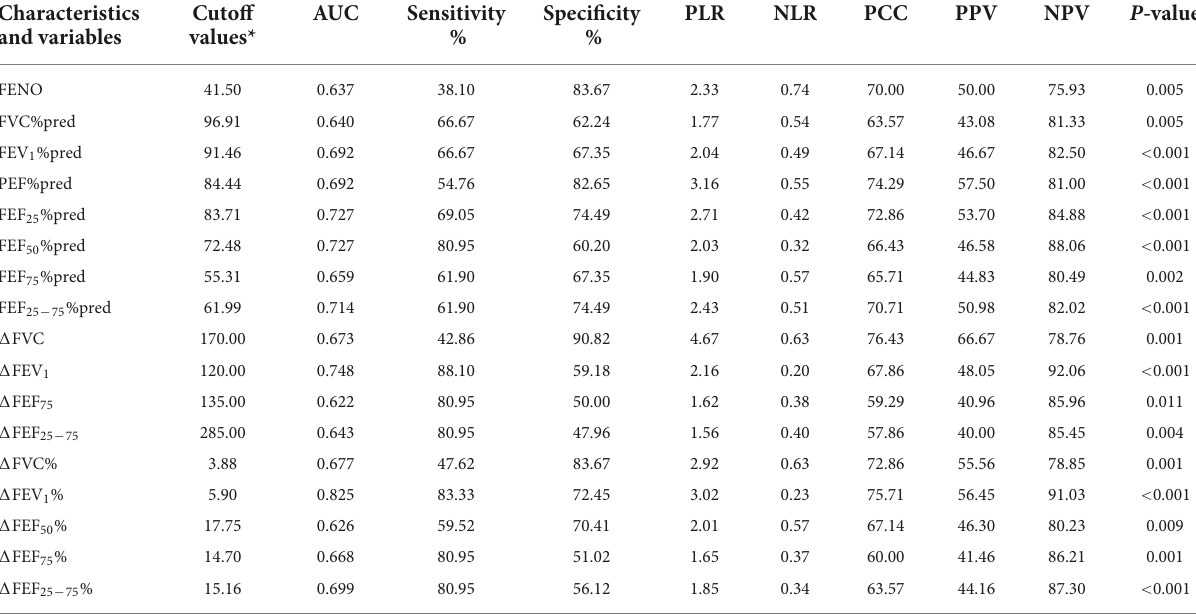
AUC, area under the curve; PLR, positive likelihood ratios; NLR, negative likelihood ratios; PPV, positive predictive value; NPV, negative predictive value; PCC, percentage correctly classified; P -value, the p value of logistic regression test. ∗ The cut-off points were selected by maximizing the sum of sensitivity and specificity; The other abbreviations are as defined in Table1 . (cid:49) FEV 1 % + FENO was higher than FEF 25 − 75 %pred + FENO ( p = 0.051) ( Figure 1D